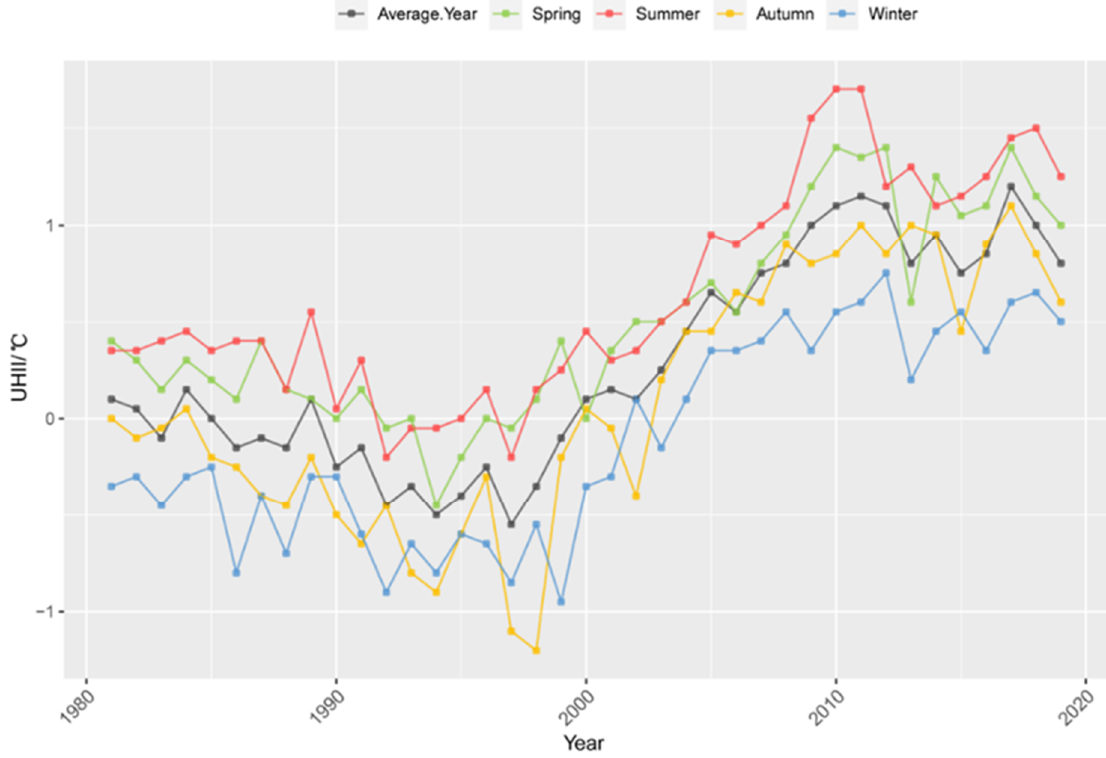
Figure 3. Averages of the atmospheric UHI intensity (UHII) in Zhengzhou from 1981 to 2019 by year and season.